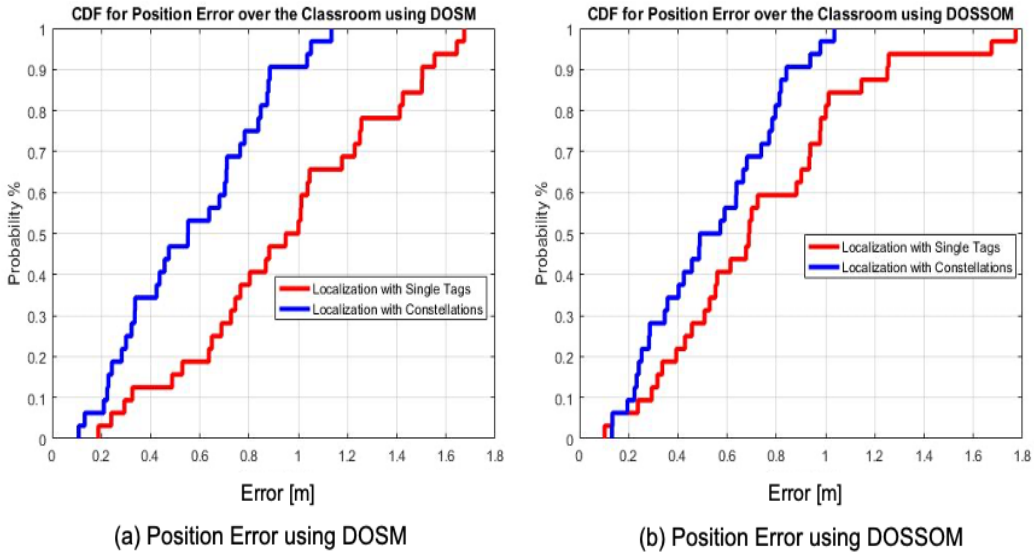
Figure 14. Cumulative Distribution Function (CDF) for the estimated position error using the multilateration technique for the classroom environment.